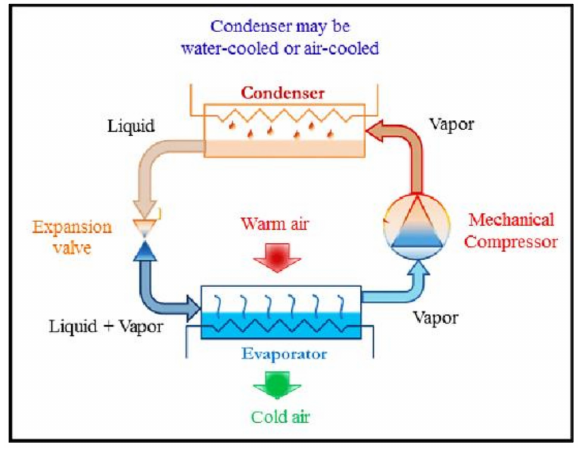
Figure 1. Schematic diagrams of the Vapor Compression Refrigeration System